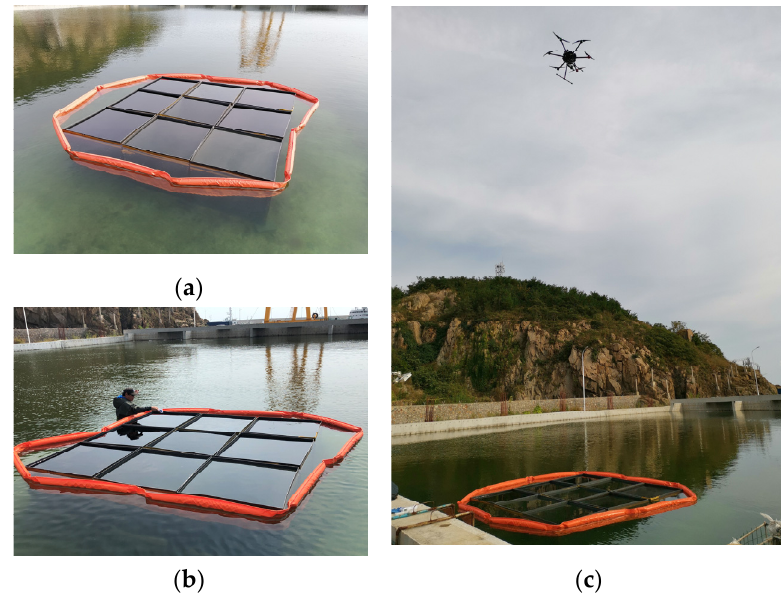
Figure 7. ( a – c ) are on-site photos of the experiment. Environmental data such as wind speed and temperature were obtained with a Kestrel- 3500 meteorological instrument (Table 3). During the UAV hyperspectral remote sensing data collection, the weather was clear, and there was no cloud or fog obstruction. From T1 to T3, the wind speed gradually increased, but the overall wind speed and wind speeds in all directions were below 2 m/s, which is classed as “light air” according to the Beaufort Scale, and the sea was relatively calm. Table 3. Environmental data of the